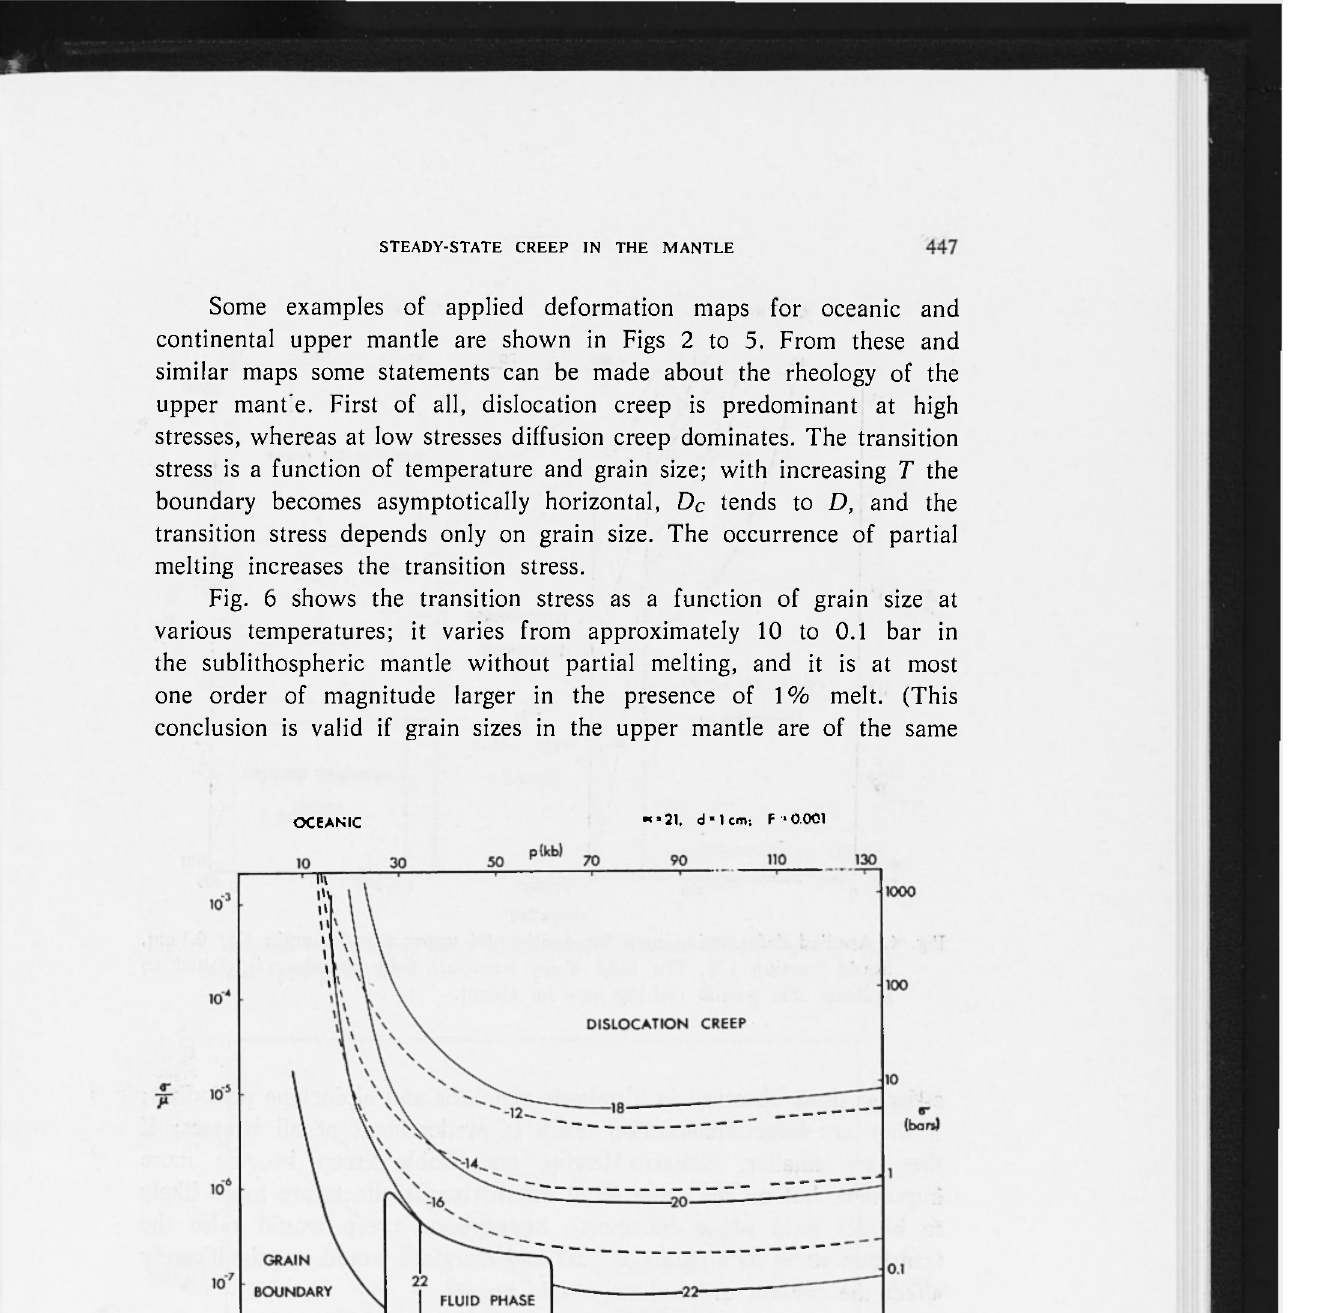
Fig. 5. Applied deformation map for oceanic upper mantle, grain size 1 cm, liquid fraction